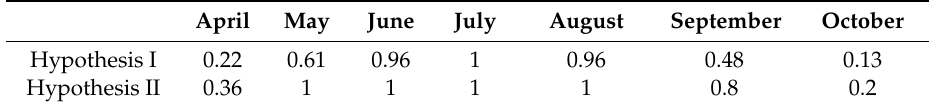
Table 4. Usability coefficient for “irrigation” (Hypothesis I) and “integrated irrigation” (Hypothesis